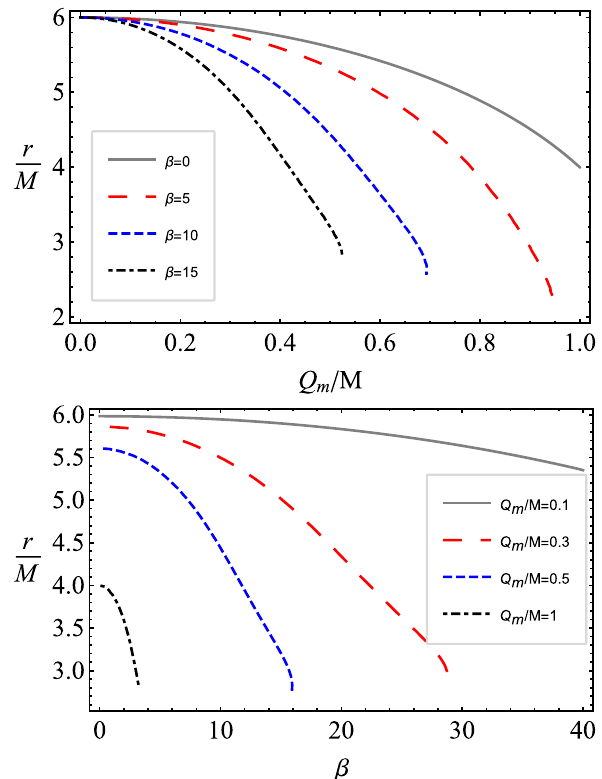
Fig. 5 DependenceoftheISCOradiusofamagnetizedparticlearound the magnetically charged RN black holes from the magnetic charge (top panel) and the parameter β (bottom)